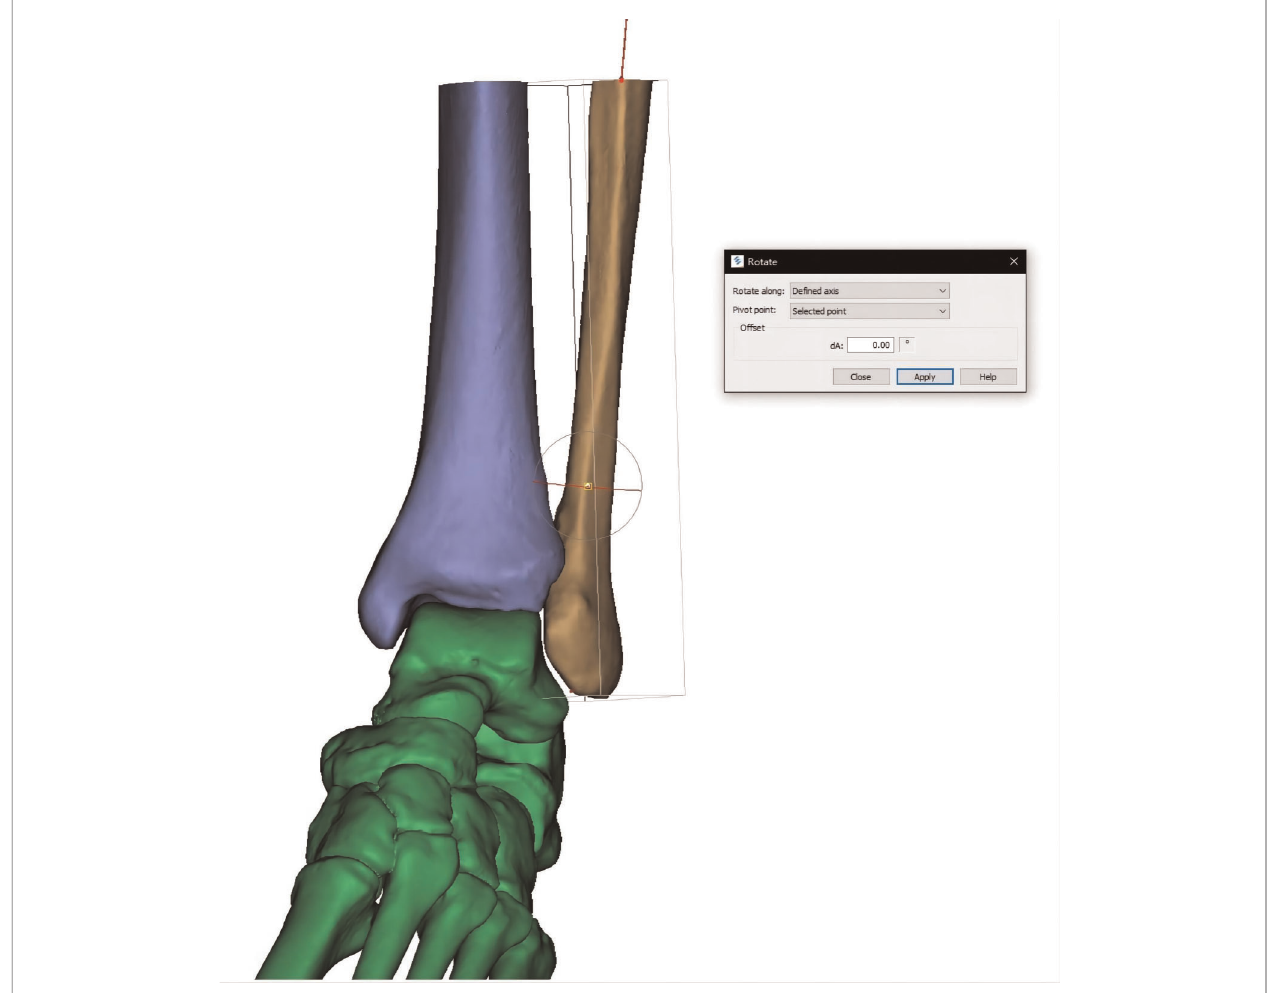
FIGURE 2 | Line coinciding with the center of the fi bular medullary cavity is delineated as the longitudinal axis. The fi bular model rotates according to the axis to simulate the rotational